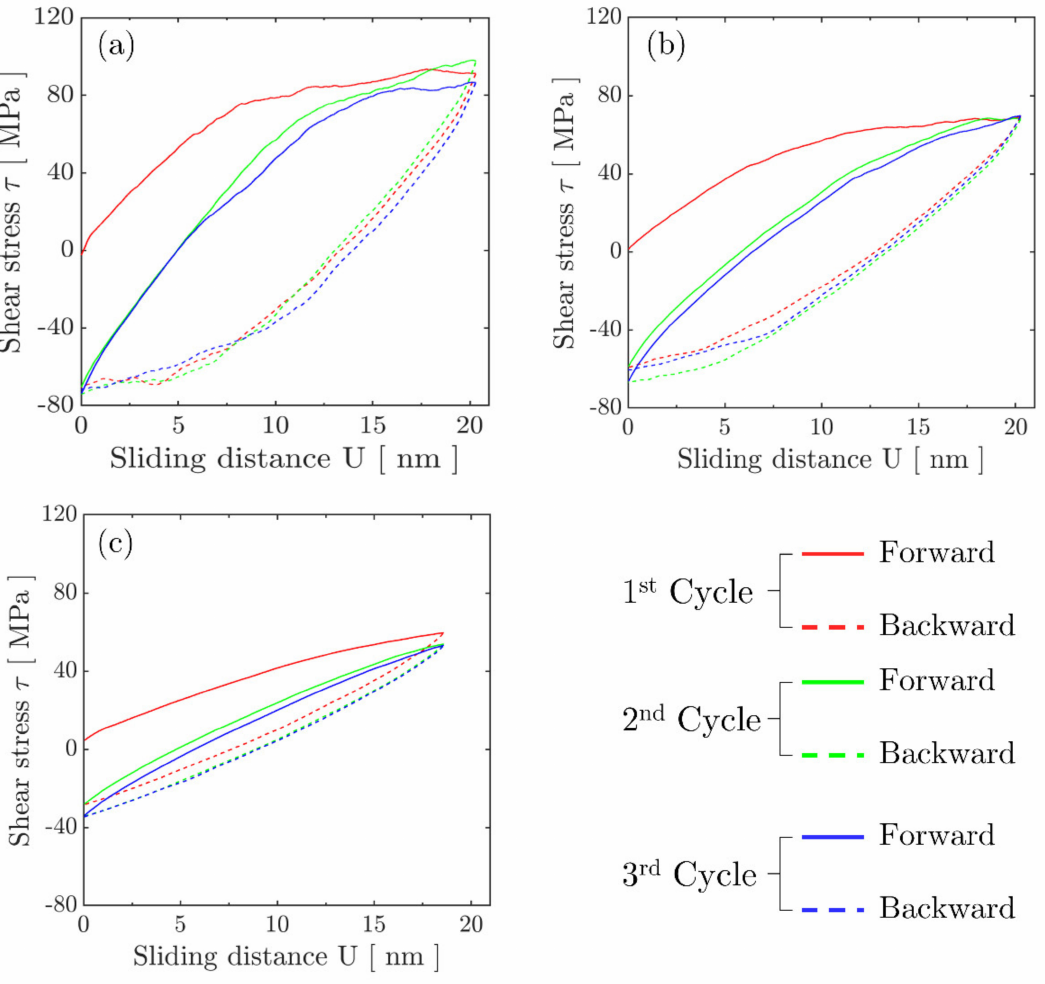
Figure 5. The shear stress evolution along the contact surface during the first 3 cycles for contact size ( a ) A = 2.4 µ m, ( b ) A = 4.1 µ m, and ( c ) A = 9.3 µ